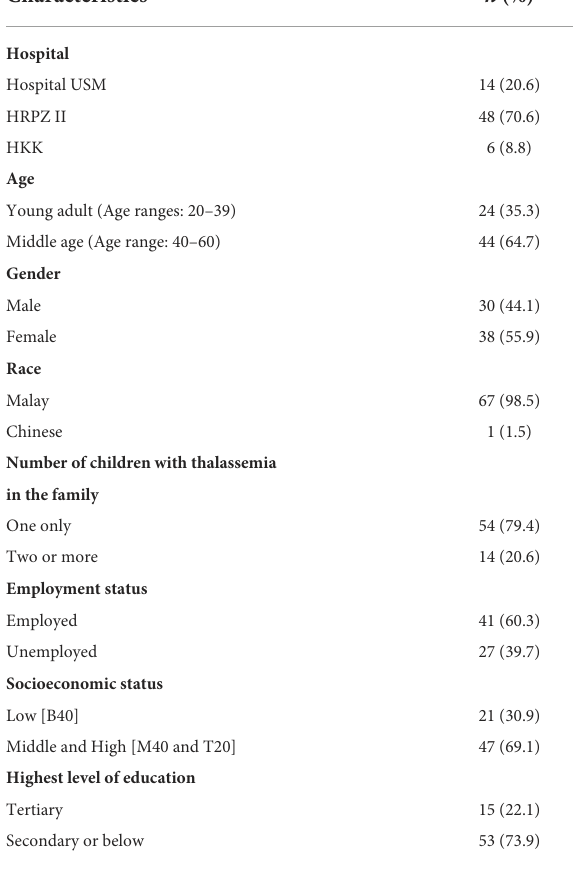
( N = 68). Characteristics